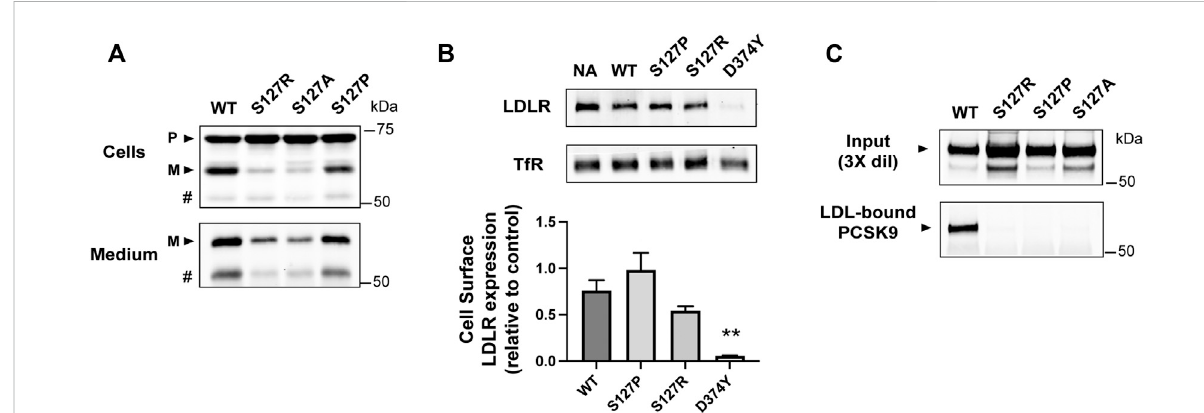
FIGURE 3 Ser-127 residue is critical to LDL binding function of PCSK9. (A) 24 h post-transfection, HEK293 cells transiently expressing WT-PCSK9 or indicated S127 mutants were harvested and cell lysates and medium immunoprecipitates were analyzed by 8% SDS-PAGE and western blotting to detectprecursor(P)andmature(M)formsofPCSK9.#indicatesafaster-migratingformofPCSK9consistentwithfurin-mediatedproteolysis.Shown isarepresentativeexperiment( n =3) (B) MouseHepa-1c1c7cellsculturedinsterol-depletingmediumweretreatedfor4 hwithWTorindicated mutant forms of PCSK9 (2.5 μ g/ml). Biotinylated cell surface LDLRs were isolated and quanti fi ed by Western blotting using transferrin receptor (TfR) asaloadingcontrol.Shownarerepresentativewesternblots( top )with densitometricanalysis ofthreeindependent experiments( bottom ).Errorbars represent SEM ( n = 3). Signi fi cant change in LDLR expression compared to WT-PCSK9 was determined by Student ’ s t -test: ** p < 0.01. (C) Conditioned cell culture medium containing WT-PCSK9 (WT) or indicated mutants were incubated with LDL prior to density